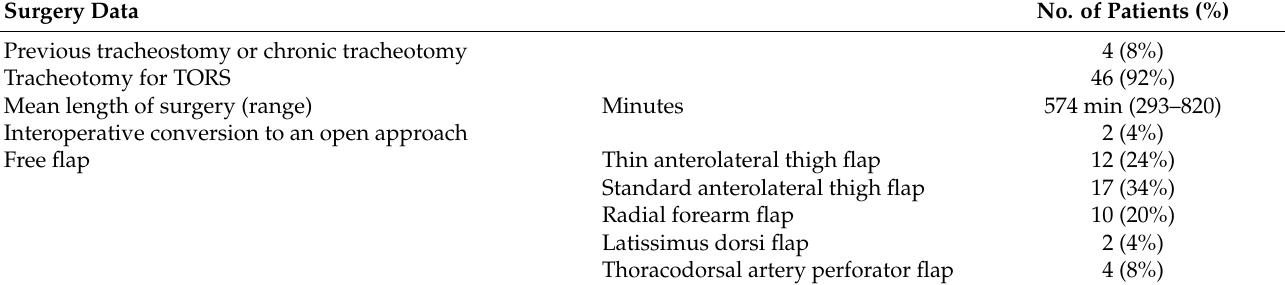
Table 2. Surgical characteristics of the first 50 patients who underwent transoral robotic surgery and a free flap reconstruction at our institution.